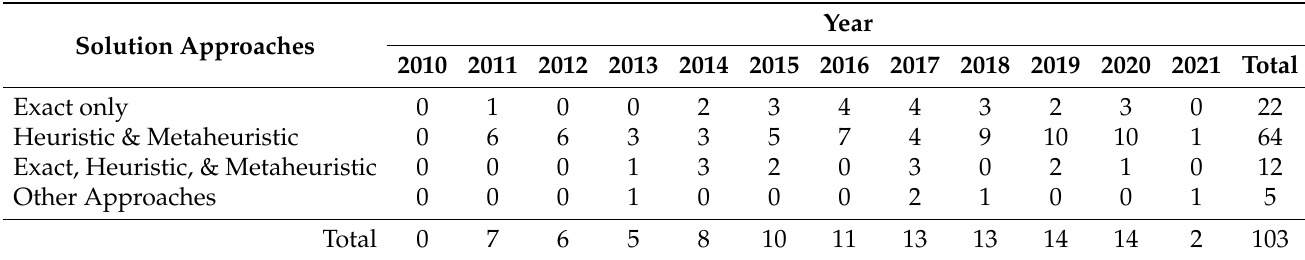
Table 7. Distribution of Papers based on the Solution Approaches over the Years.